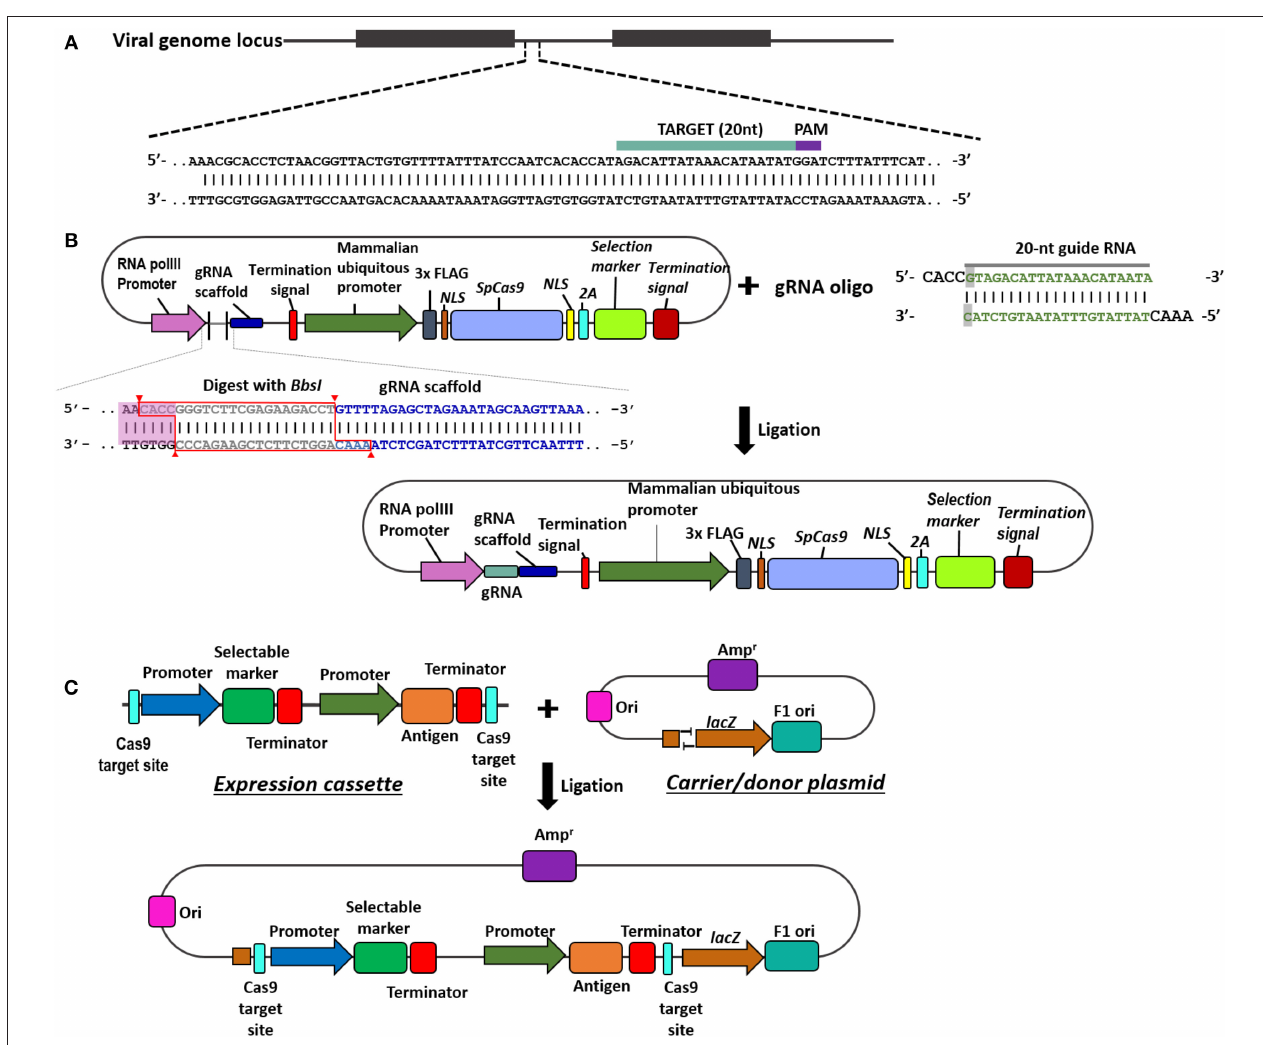
FIGURE 1 | Overview of steps in the construction of CRISPR/Cas9 and donor plasmids. (A) The 20 nucleotides viral genome target (highlighted in teal) is followed by the PAM recognition site (highlighted in purple), 5 ′ -NGG. (B) Schematic on the construction and assembly of the Cas9/gRNA expression plasmid. Digestion of the plasmid containing Cas9 and gRNA scaffold with BbsI allows the insertion of the annealed gRNA oligos (teal) through replacing the type II restriction site (outlined in red). (C) Schematic on the construction of the donor plasmid harbouring the antigen and selectable marker. The T overhangs on the carrier plasmid is complementary to the overhangs in the expression cassette to facilitate